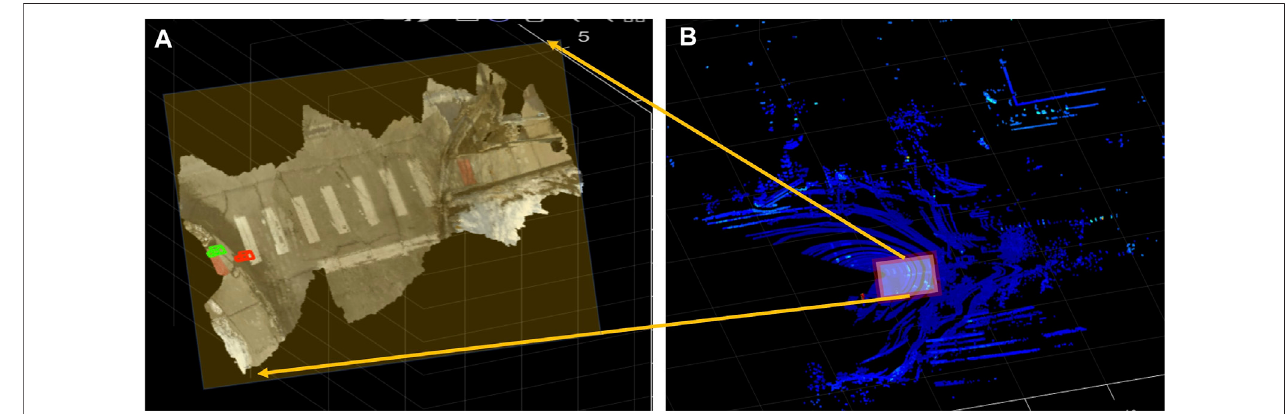
FIGURE4| Example of point cloud at ourtest intersection. (B) isregistered point cloud obtained withalidar sensor. (A) is aregistered point cloud by aZED stereo camera. Overlaying these two points clouds provides a prior map with the accuracy of lidar and the color image information of RGB-D.